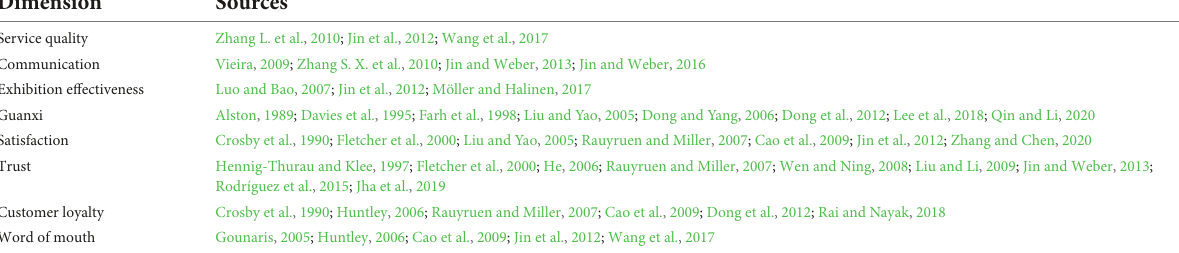
TABLE 2 Definition of variables affecting relationship quality, with their